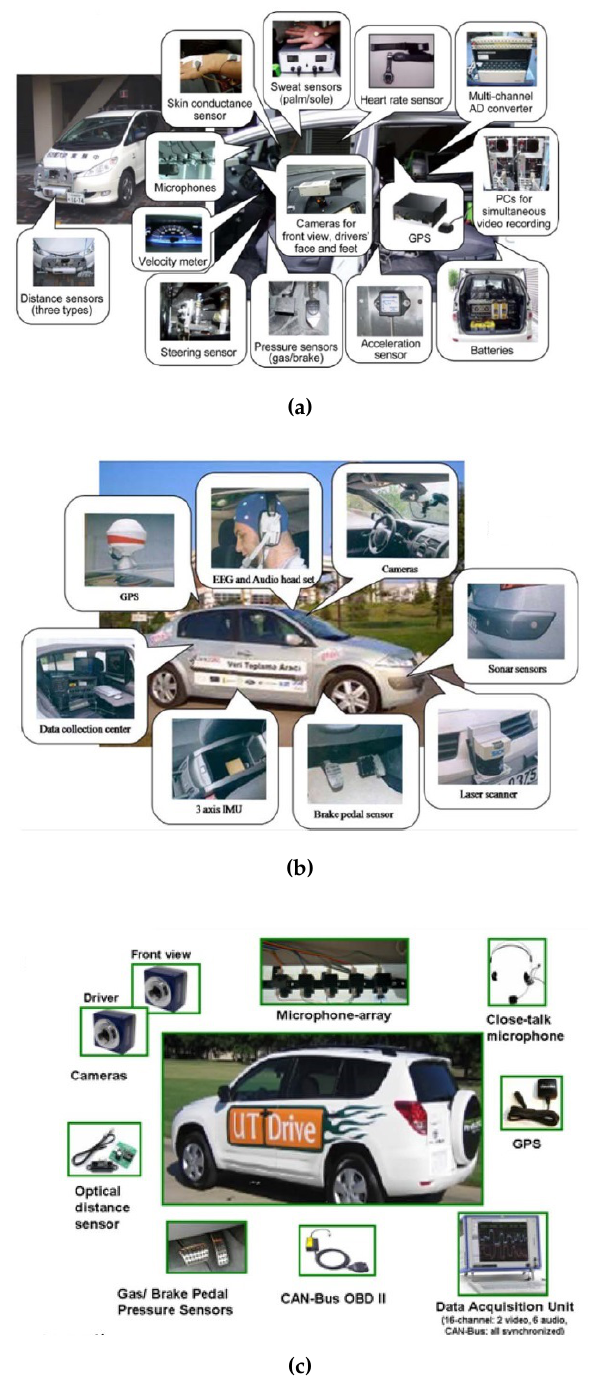
Figure 6. Sensors used for data collection in intelligent and autonomous vehicle studies [41]. ( a ) NUDrive; ( b ) Uyanik; ( c ) UTDrive.